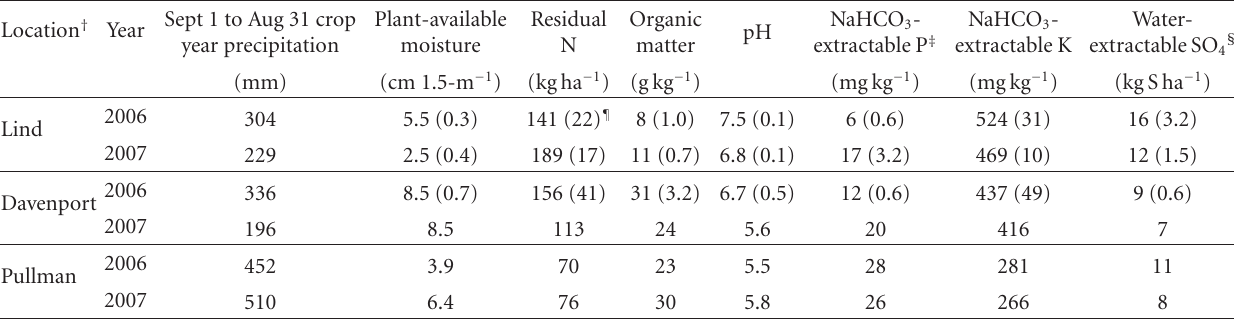
Table 1: Crop year precipitation and preplant soil test information for each site-year. Plant-available soil moisture is calculated by the commercial testing lab from gravimetric moisture content, an assumed bulk density of 1.2g cm − 3 for silt loam soil textures, and an assumed permanent wilting point moisture content of 11% by